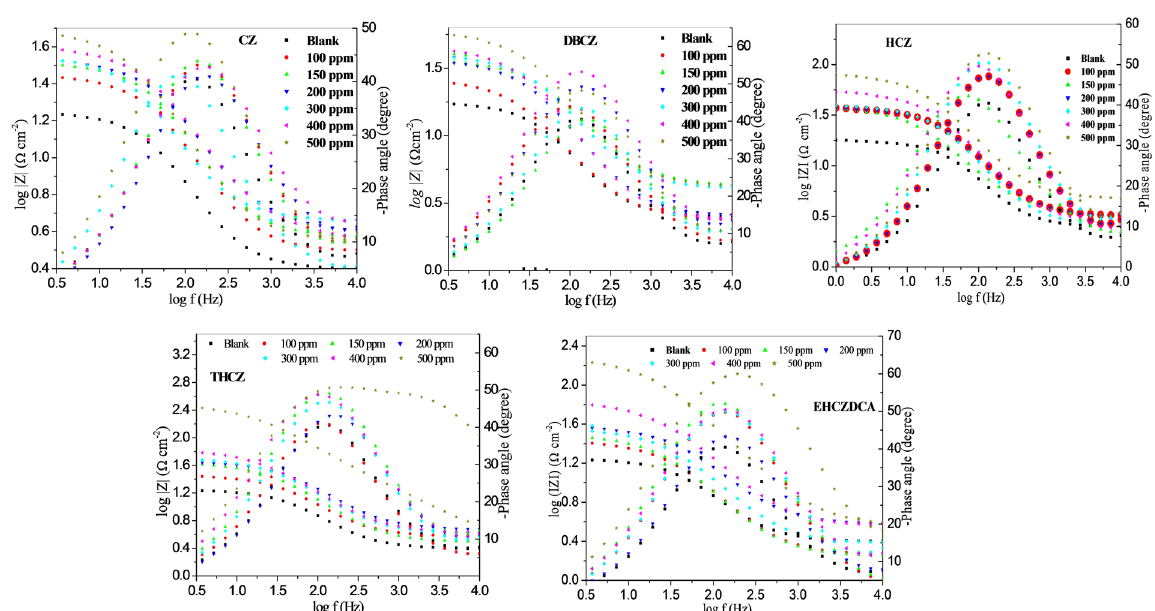
Figure 3. Bode impedance modulus and phase angle plots for mild steel in 1 M HCl in absence and presence of different concentration of